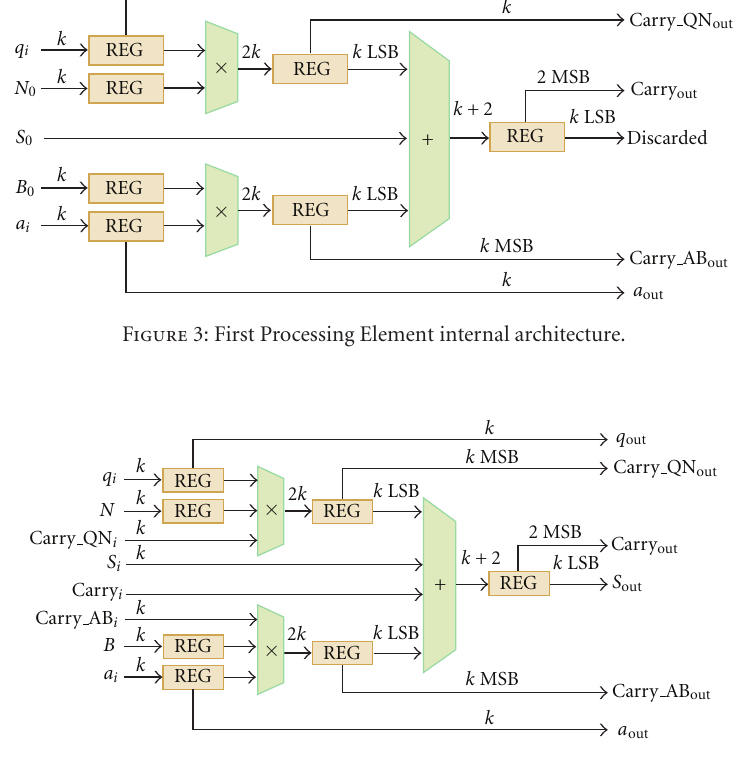
Figure 4: General processing element internal architecture.